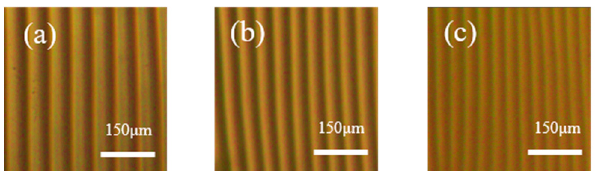
Figure 2. Optical images showing the profiles of wrinkle patterns with different wavelengths at sample positions of ( a ) 0.6 mm, ( b ) 3.0 mm, and ( c ) 4.5 mm. Corresponding distances between the lamp and PDMS substrate d were ( a ) 7.83 mm, ( b ) 9.15 mm, and ( c ) 9.98 mm.